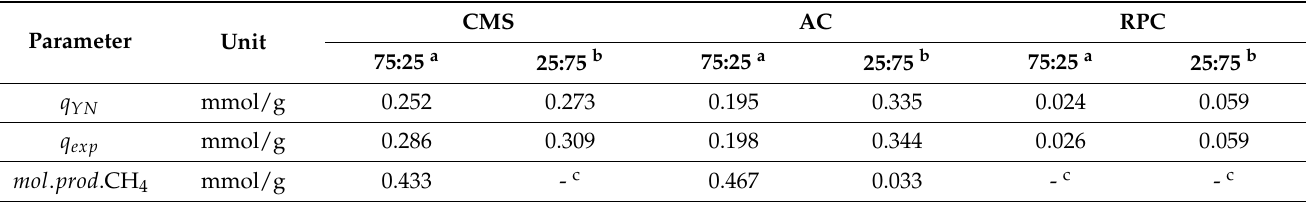
Table 3. Theoretical and experimental dynamic adsorption capacities of a column and molar productivities of CH 4 .